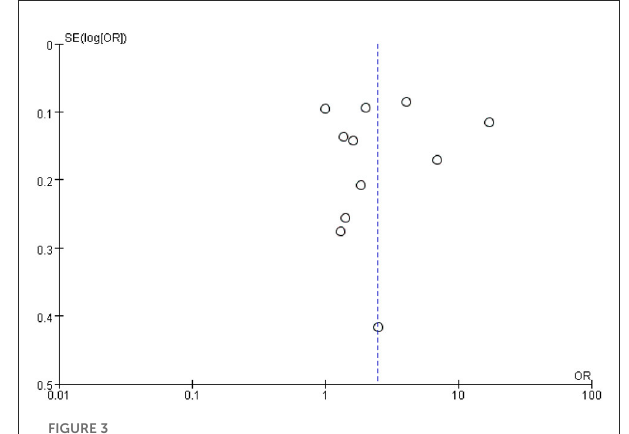
FIGURE3 A funnel plot for the sensitivity